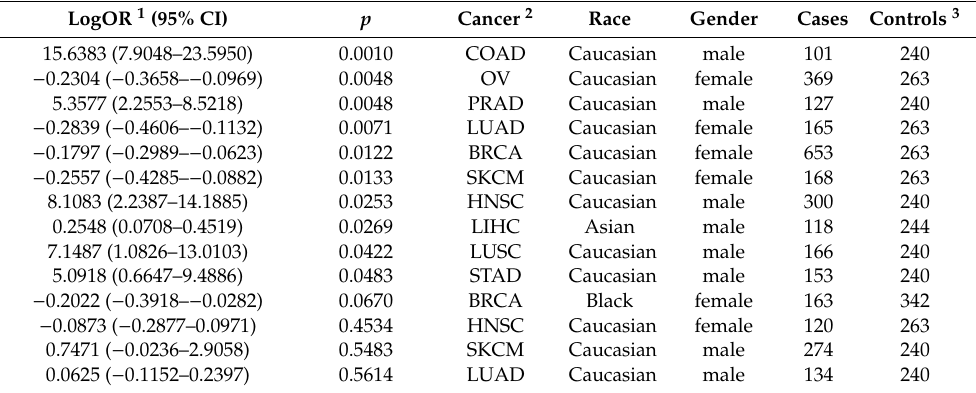
Table 2. Results from logistic regression assessing ROH’s cancer